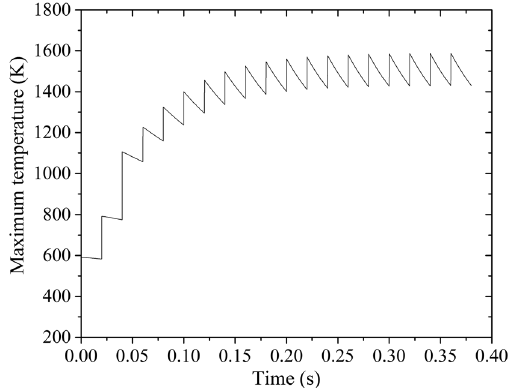
FIG. 4. Maximum temperature of the carbon wire with time (the beam pulse width is 50 μ s and repetition frequency is 50